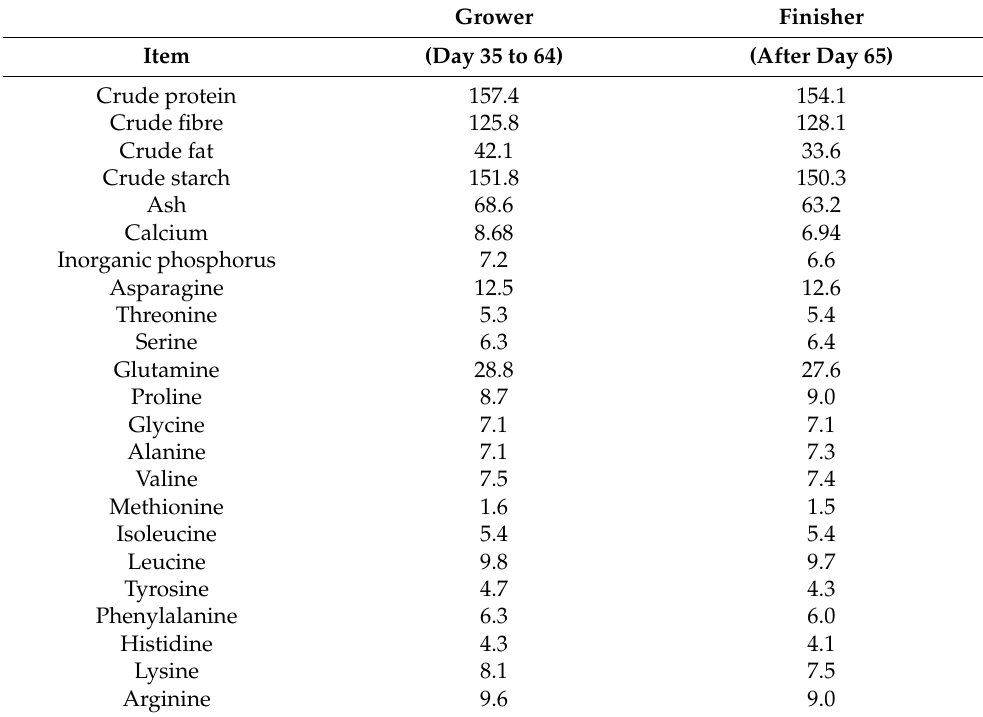
Table 1. Chemical composition (g/kg) of the diets as-fed basis. Grower